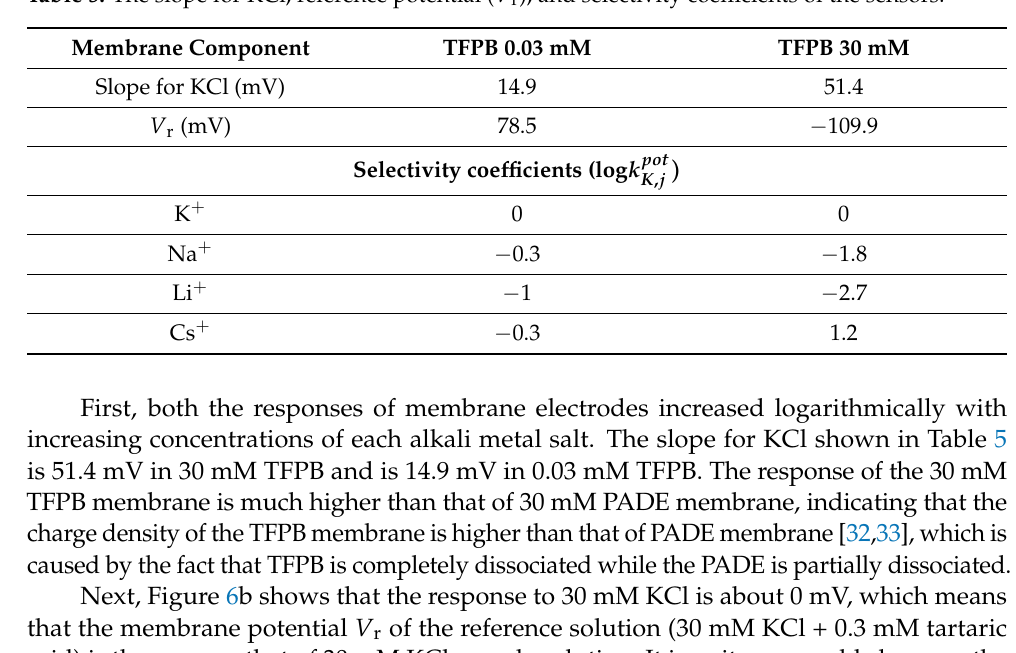
Figure 6. Sensor responses ( V s − V r ) to alkali metal salts samples: ( a ) Low TFPB concentration (0.03 mM); ( b ) high TFPB concentration (30 mM). Table 5. The slope for KCl, reference potential ( V r ), and selectivity coefficients of the